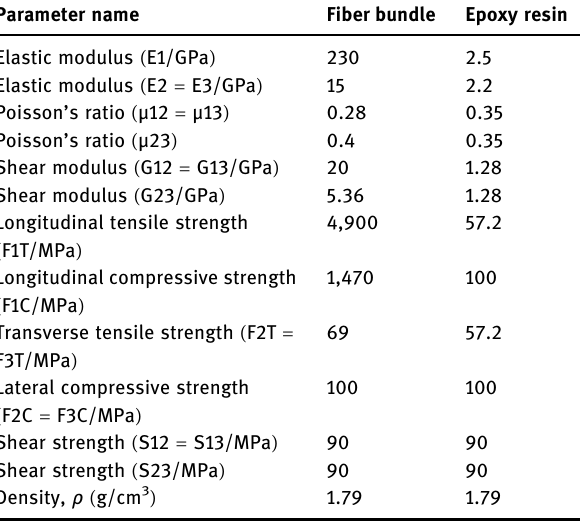
Table 1: The parameters of epoxy resin and fi ber bundle